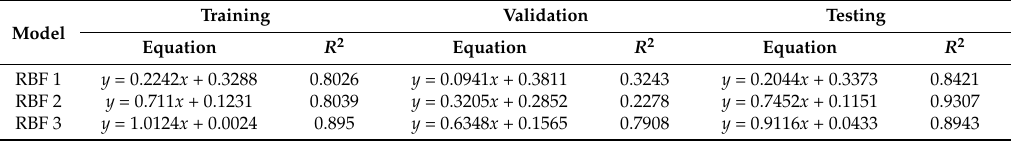
Table 11. Results of different RBF models in the training, validation and testing phases.